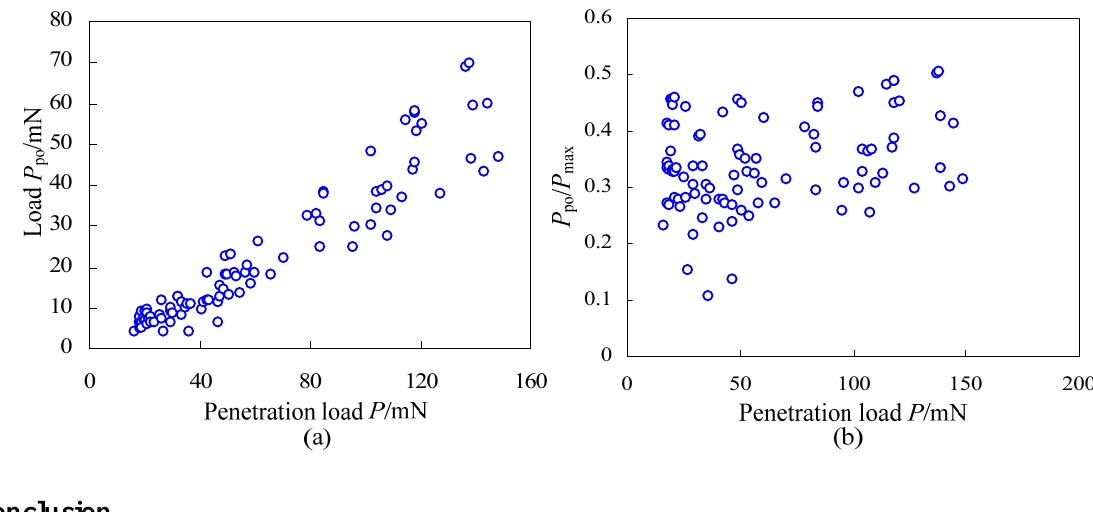
Figure 7. ( a ) The load P for appearance of pop-out versus the maximum penetration load po / P versus the penetration and ( b ) P po max